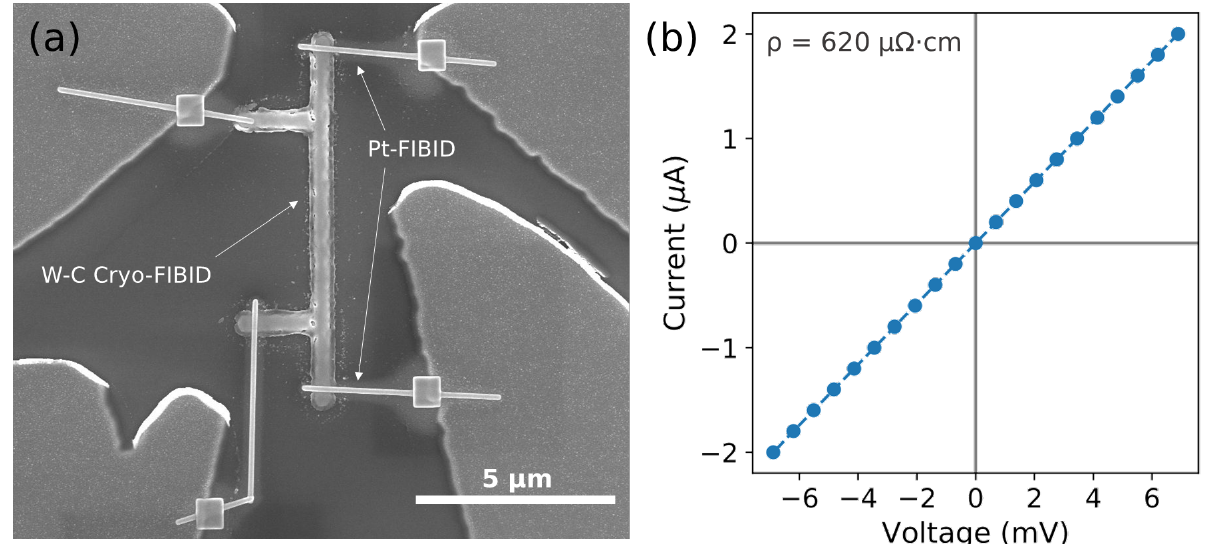
Figure 3. ( a ) SEM image of a W–C Cryo-FIBID nanowire grown using an ion dose of 200 µ C/cm 2 , joined to Ti pads by Pt-FIBID contacts. ( b ) Current–voltage characteristics of the nanowire. The dashed line indicates a linear fit that yields a resistance of 3.44 k Ω